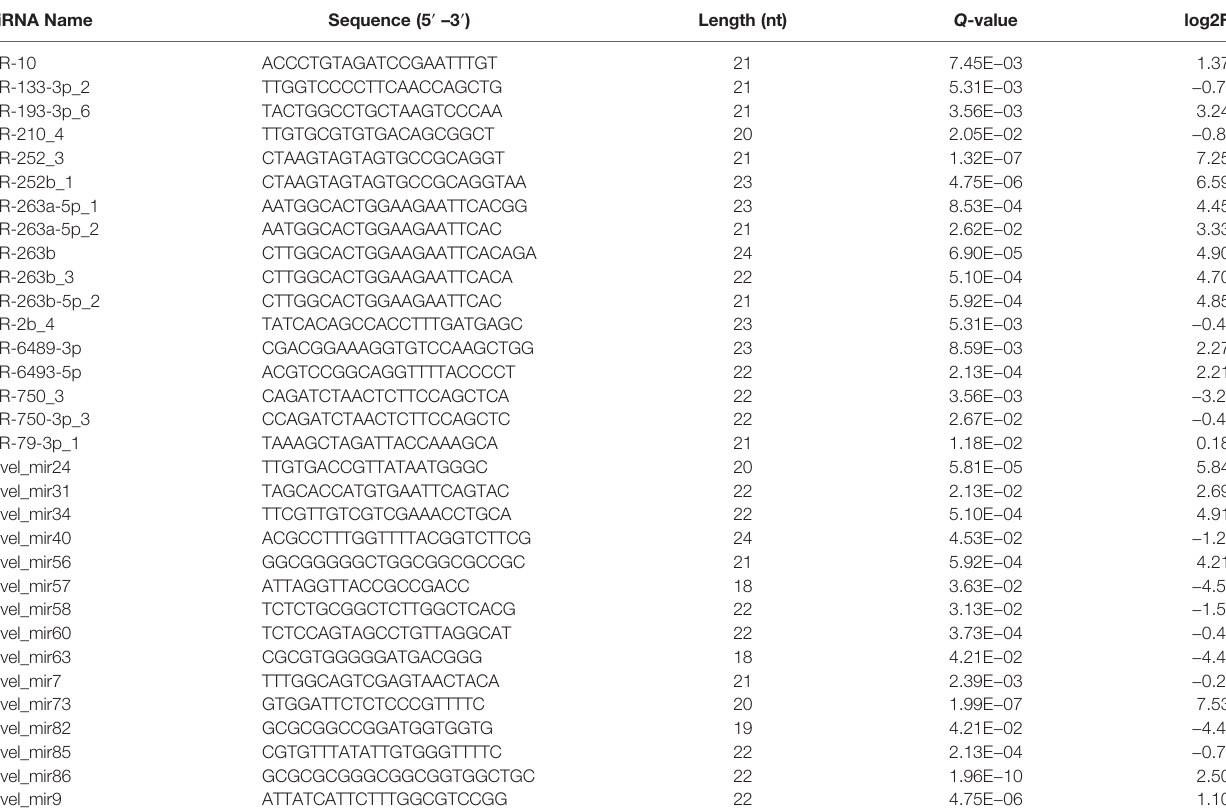
TABLE 4 | Identi fi cation miRNAs and their